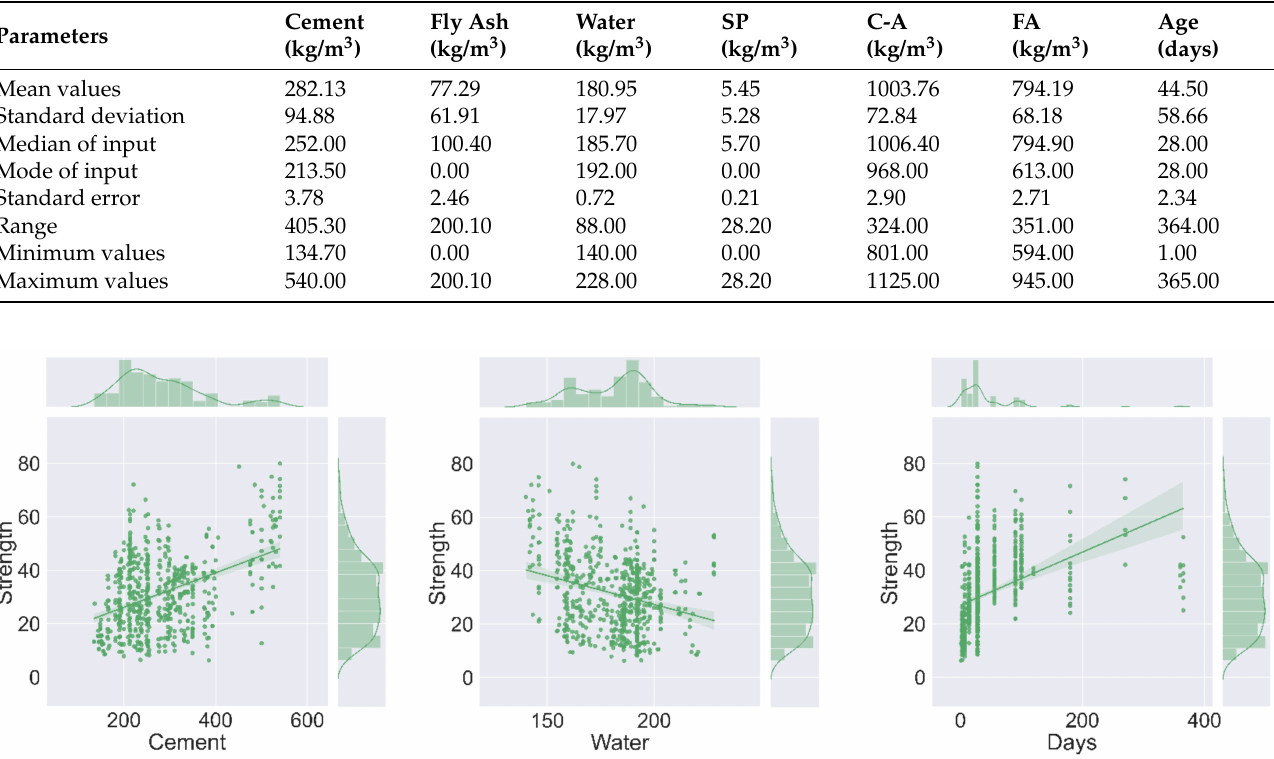
Table 2. Explanation of the statistical analysis for the input parameters.